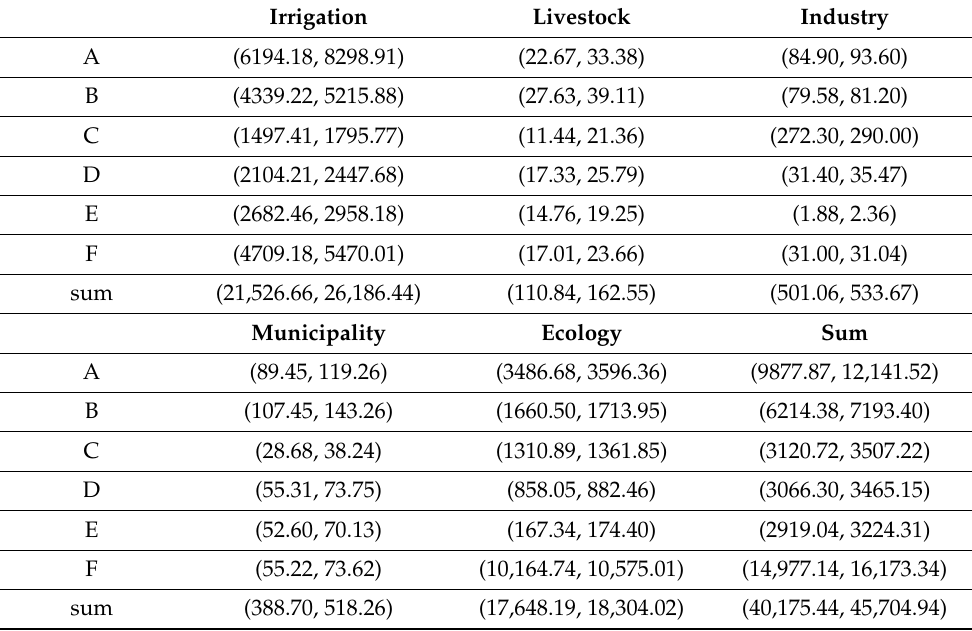
Table 6. The water demand in different water sectors in different states (unit: million m 3